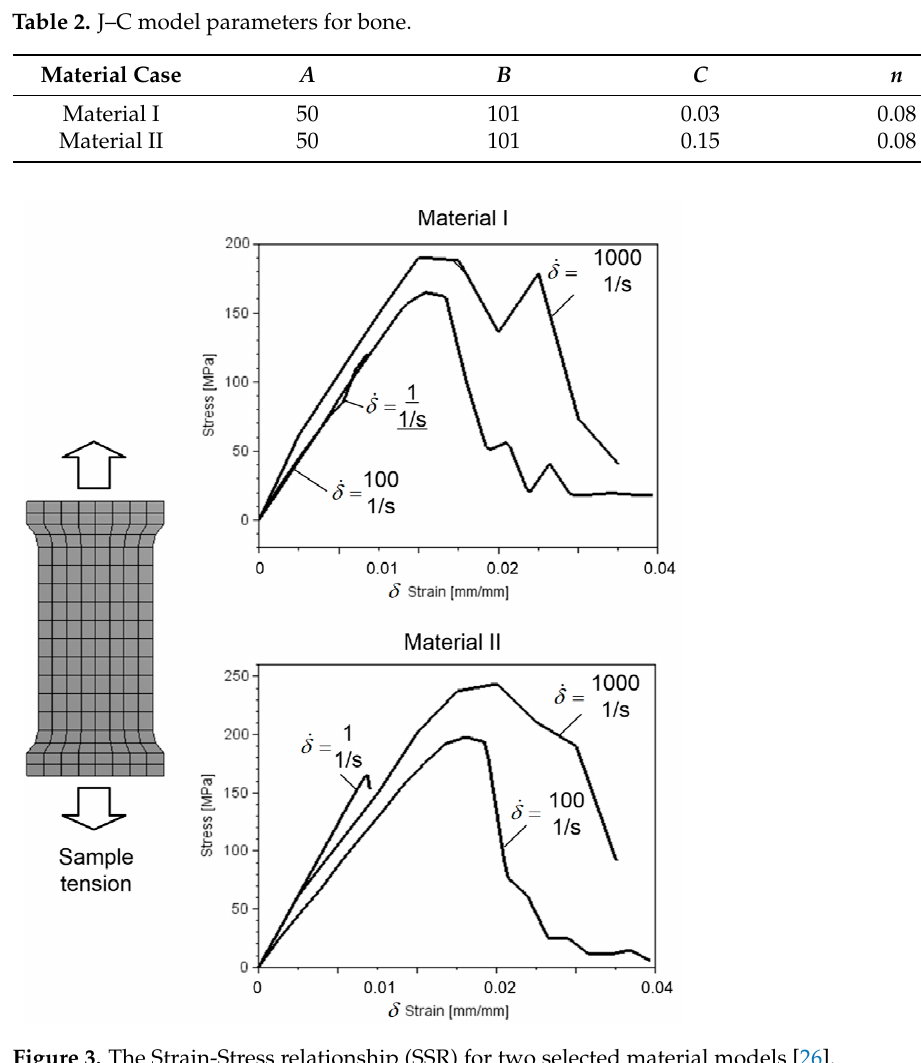
Table 2. J–C model parameters for bone.